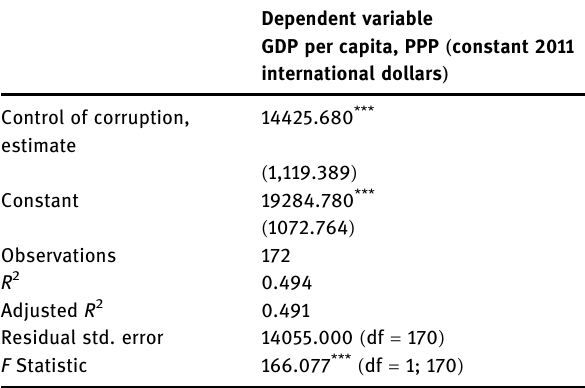
Table 1: Regression results: Control of corruption against real